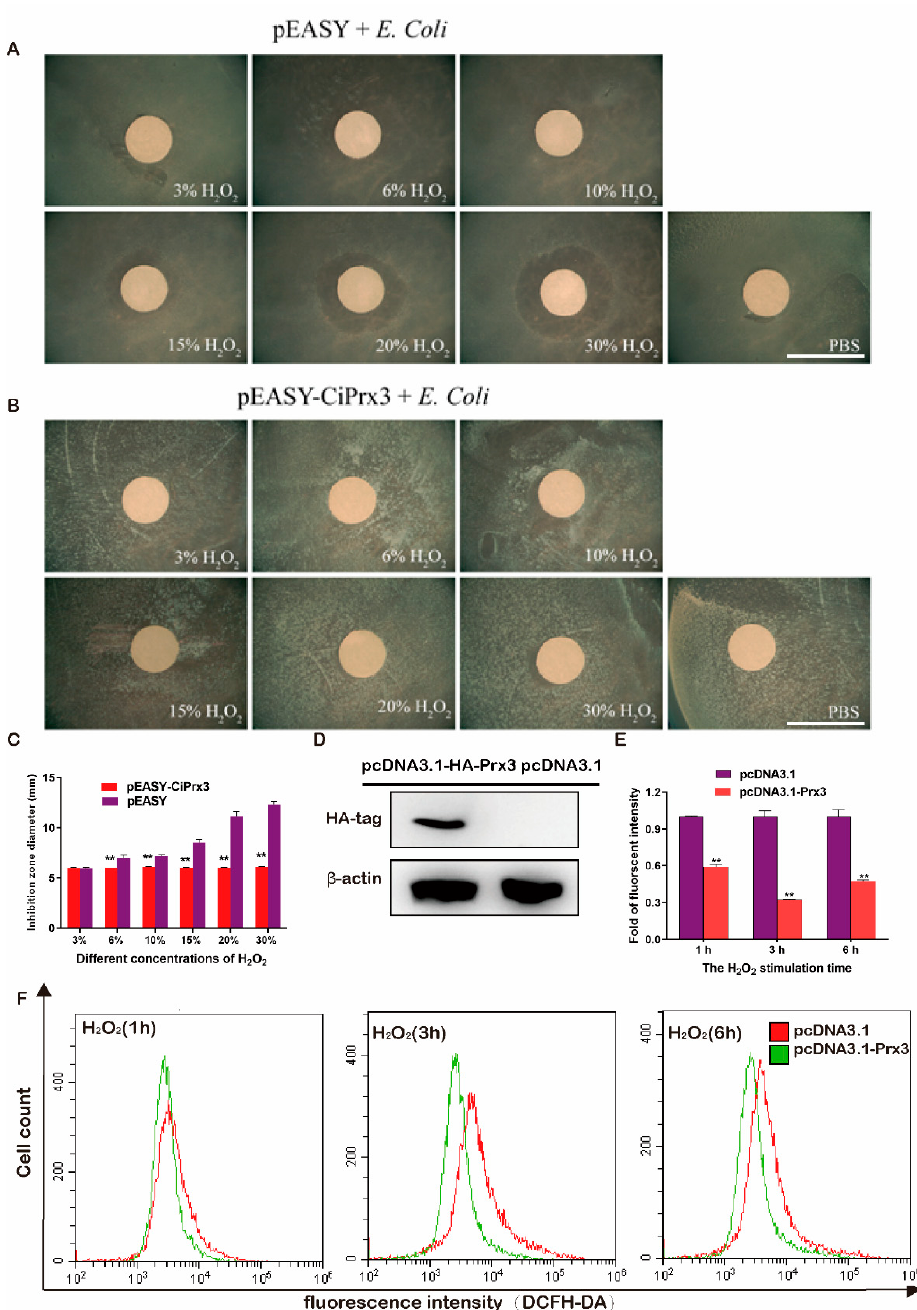
Figure 5. The antioxidant activity of CiPrx3 . ( A , B ) E. coli BL21 strains were transformed with pEASY- Blunt or pEASY- CiPrx3 and cultured in agarose plates treated with different concentrations of H 2 O 2 . Scale bar =1 cm. ( C ) Inhibition zone diameter of E. coli after H 2 O 2 stimulation. ( D ) Confirmation of the overexpression of CiPrx3 in GCO cells by Western blotting. GCO cells were transfected with pcDNA3.1- CiPrx3 or pcDNA3.1 and harvested at 24 h for Western blotting by using an anti-HA antibody. ( E ) Calculation of relative fluorescence intensity of ROS in pcDNA3.1- CiPrx3 or pcDNA3.1 transfected cells. ( F ) CiPrx3 reduced the intracellular ROS caused by H 2 O 2 stimulation. GCO cells were transfected with pcDNA3.1- CiPrx3 or pcDNA3.1 and then treated with H 2 O 2 (0.4 mM) and collected at different time points (1 h, 3 h, and 6 h) to detect the intracellular ROS by flow cytometry. Data were shown as the mean ± SD ( n = 3). Asterisks represent significant differences (** = p ≤ 0.01).